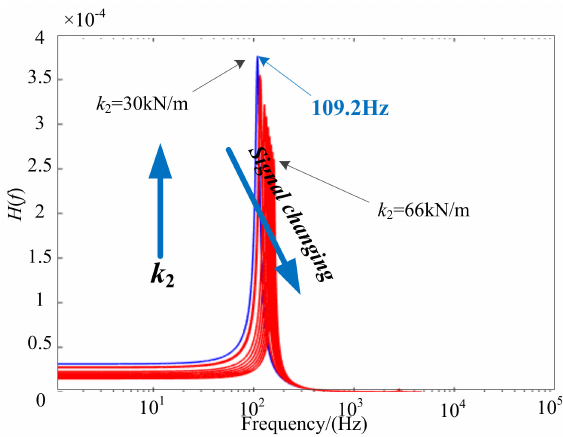
Figure 10. Effects of k 2 on the frequency response of the plastic